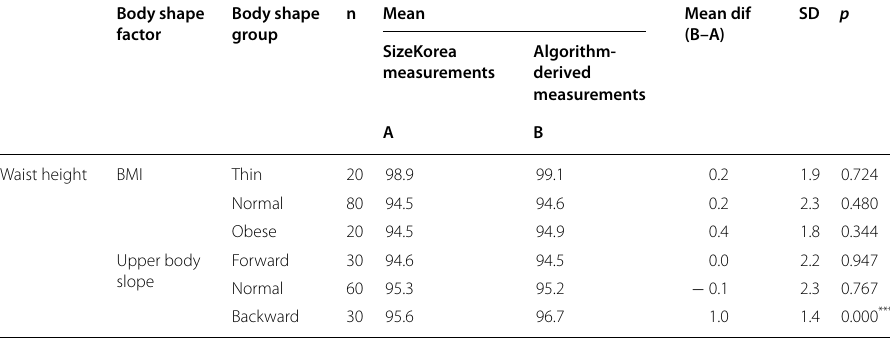
Table 9 The t -test results of the waist height (Unit: